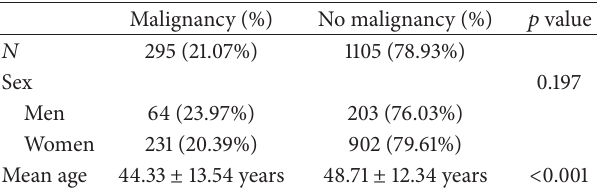
Table 1: Sex and age of thyroid cancer